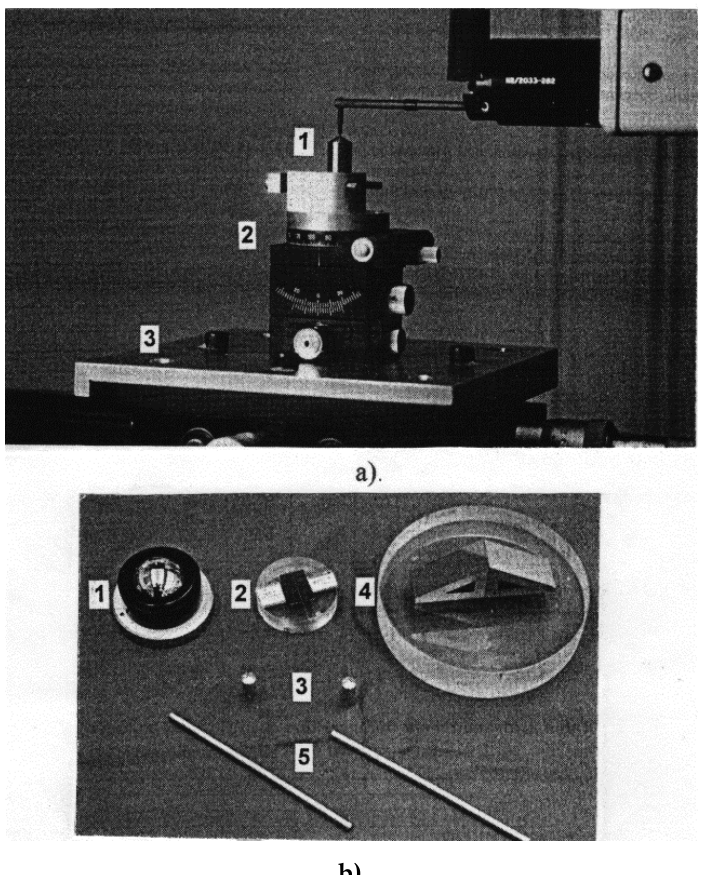
Figure 5. Cutting edge radius measuring device: ( a ) Talysurf 120L apparatus and ( b ) calibers — a steel ball with a diameter of 22 mm (1), a steel wire of 204.01 mm (2), two pieces of rubber of 198.71 mm (3), a piece of steel with a dihedral angle of 120 (4), and two steel bars (5). Using this device, we measured the cutting edge radius of the insert. The results are presented in Figure 6.